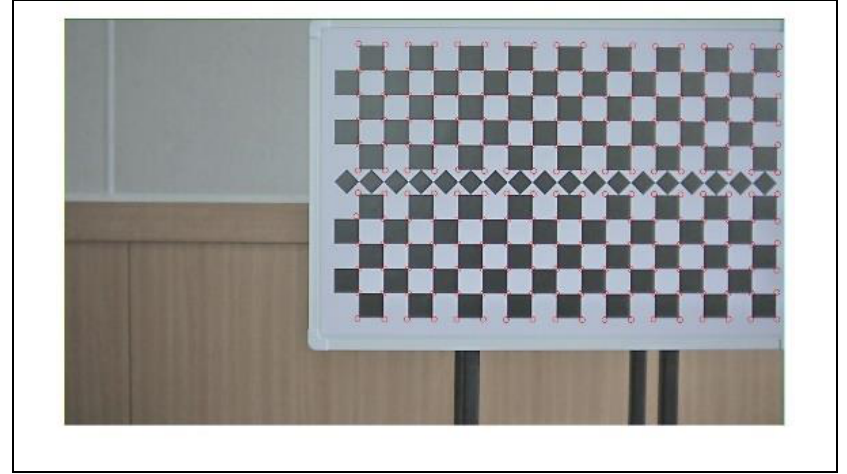
Figure 15. Detection of the square vertex on the proposed calibration board.